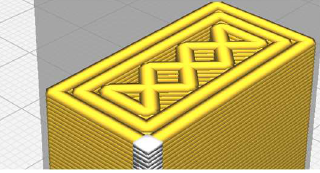
Figure 4. Cross-section of an ASTM D638-14 type IV specimen with 90% grid infill, two wall lines and ZY build orientation.